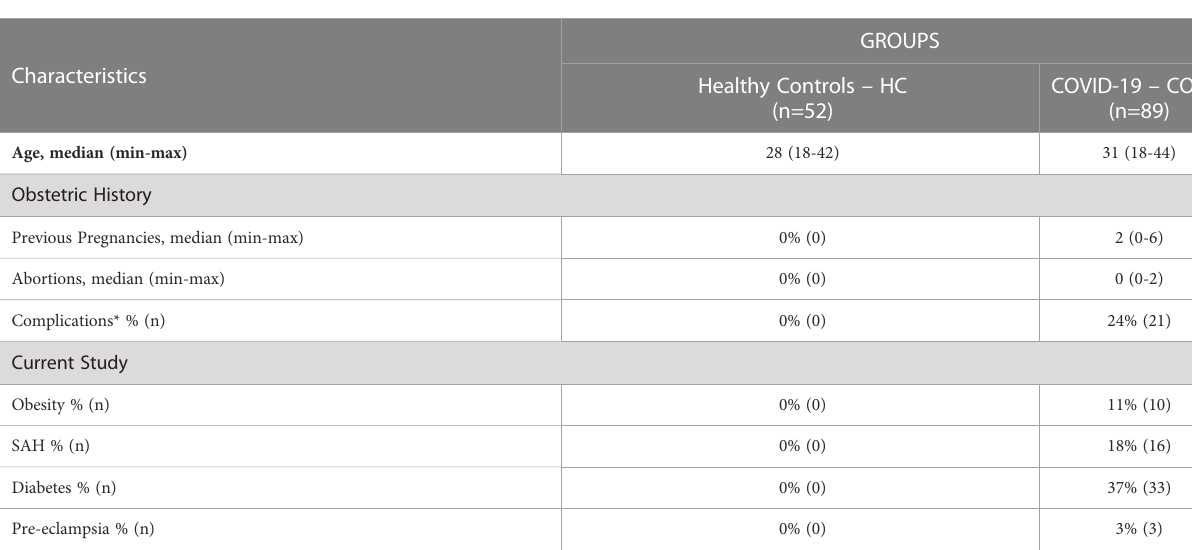
TABLE 1 Demographic and clinical features of the study